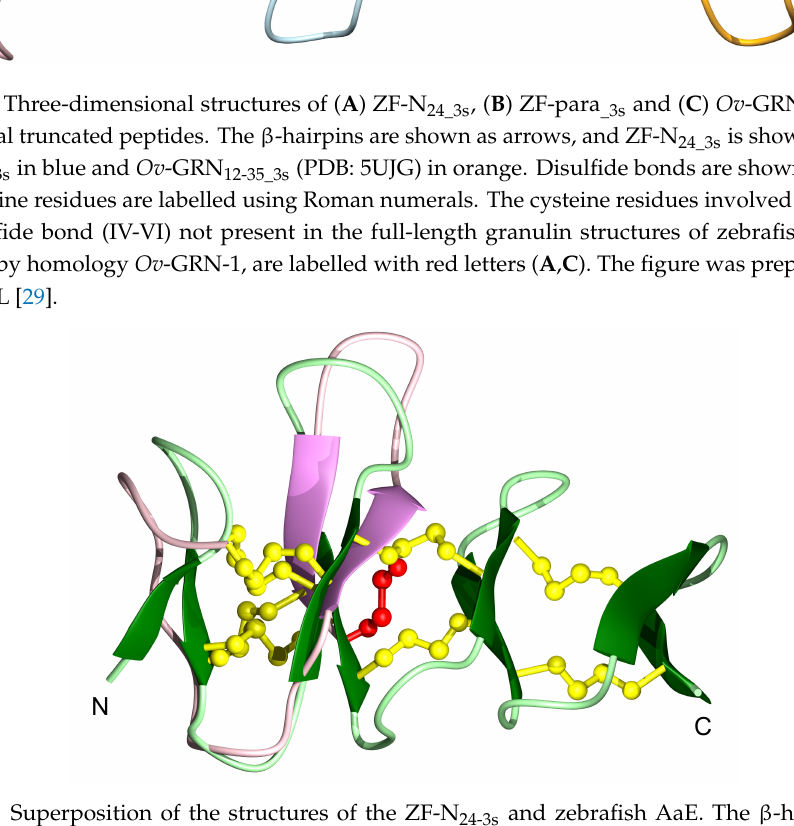
Figure 5. Superposition of the structures of the ZF-N 24-3s and zebrafish AaE. The β-hairpins are shown as arrows—in violet for ZF-N 24-3s (PDB ID: 7JIA), and dark green for zebrafish AaE (PDB ID: 6cku). Disulfide bonds are shown in yellow. The cysteine residues involved in forming the non-native disulfide bond (IV-VI) in ZF-N 24-3s is shown in red. The figure was prepared using MOLMOL [29].